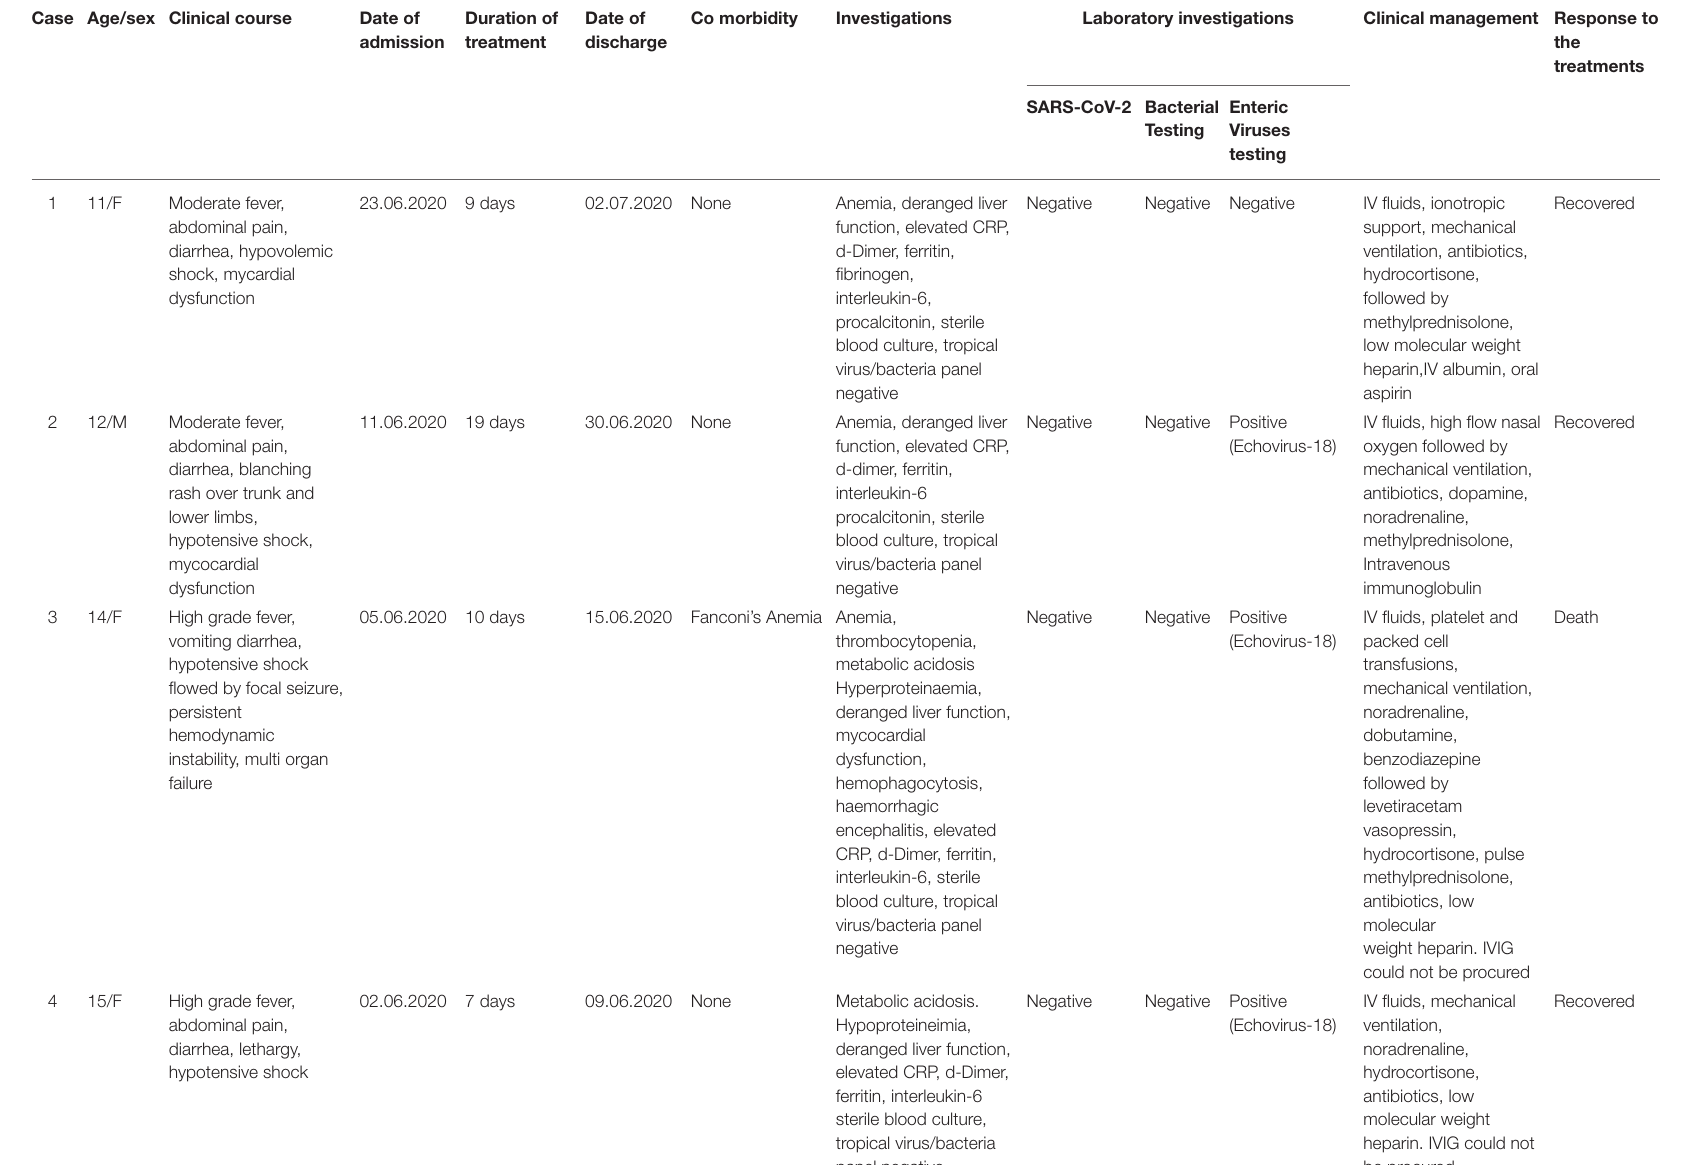
TABLE 1 | Demographic and clinical characteristics of reported cases with multisystem inflammatory syndrome in children